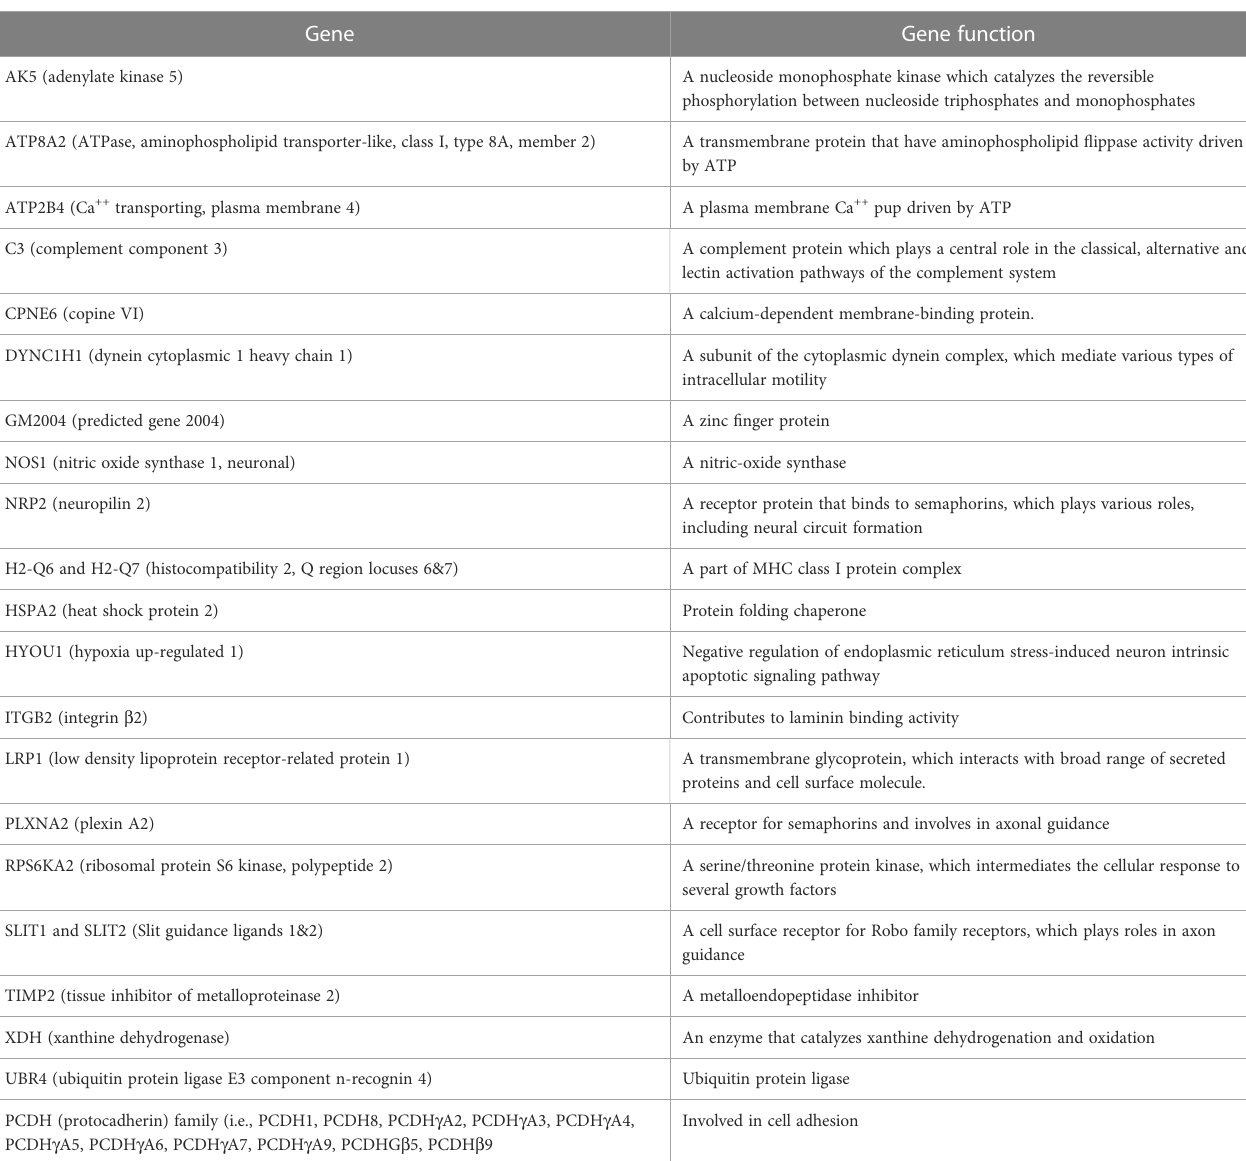
TABLE 2 Genes associated with downregulation of signaling pathways and their functions in brain and spinal cord of demyelinated mice. Gene Gene